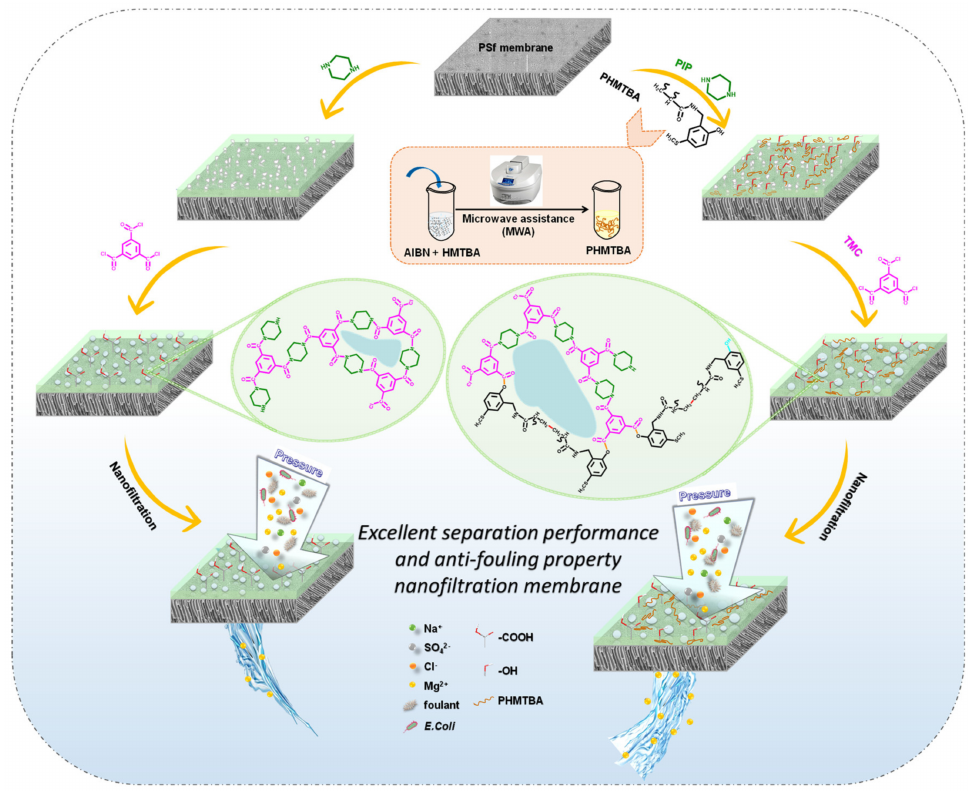
Figure 2. The schematic diagram of a fabrication process of unmodified and PHMTBA-modified TFC